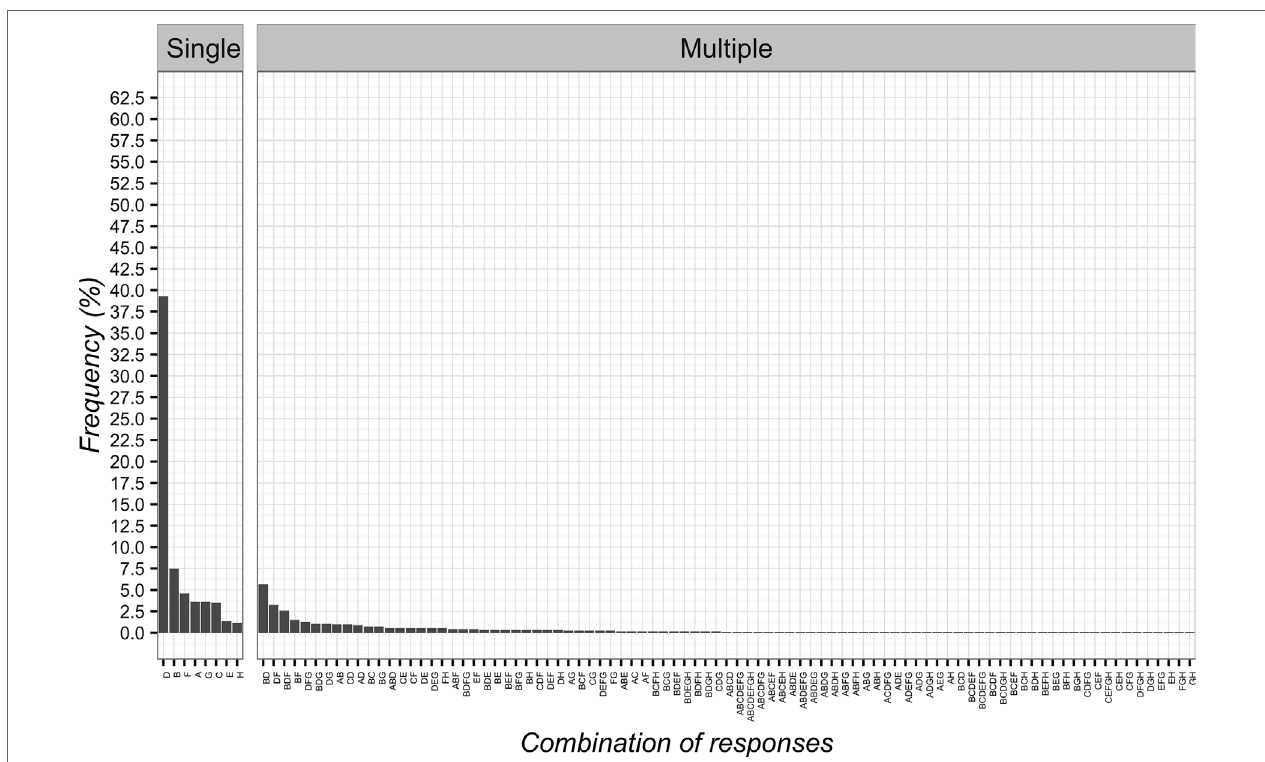
FIGURE 6 | Percentages of responses for circumstances of Contextual Factors application. (A) as a result of unjustified and constant demands for healthcare interventions; (B) to calm down the patient; (C) when all other therapies are over; (D) in addition to other interventions to optimize clinical responses; (E) for non- specific problems; (F) to gain time; (G) as a diagnostic tool to differentiate between psychological and physiological problems; (H) to control